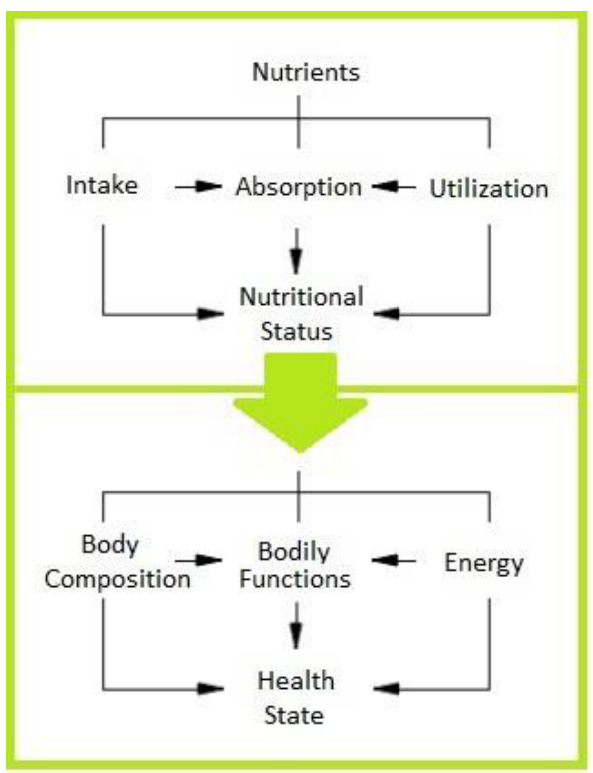
Figure 1. Nutritional status, measurable at a given time, is an integral part of the state of health. WHO defined the nutritional status “as the condition of the body, resulting from the balance of intake, absorption, and utilization of nutrients interacting with individual physiological and pathological status”. WHO, World Health Organization.